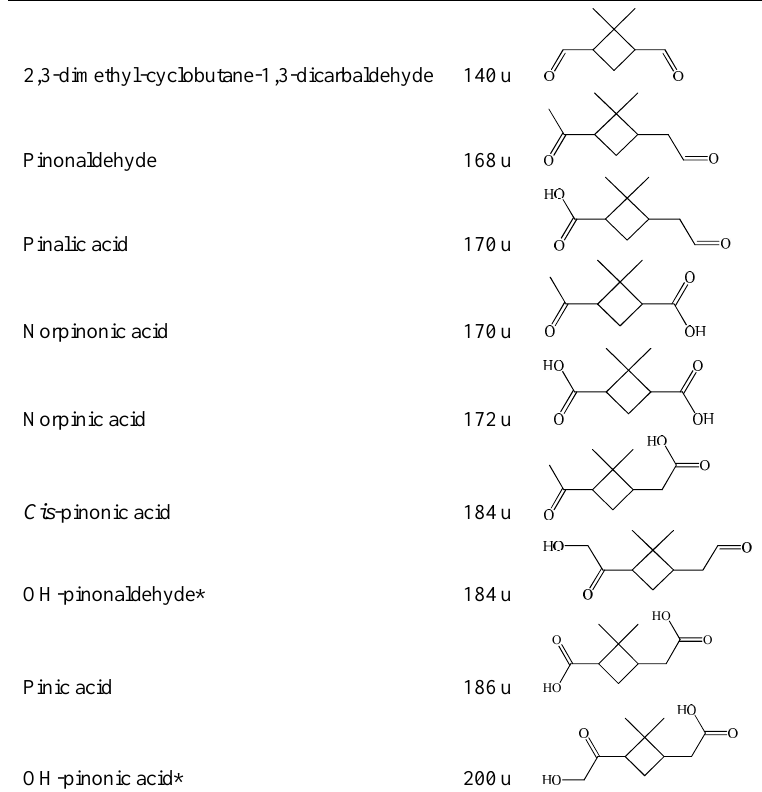
Table 1. Particle-phase products of α -pinene ozonolysis measured by NIR-LDI-AMS as the [M- 584 H] - pseudo-molecular ions. (*) Tentative assignment to one of several possible isomers (see text 585 for further discussion).